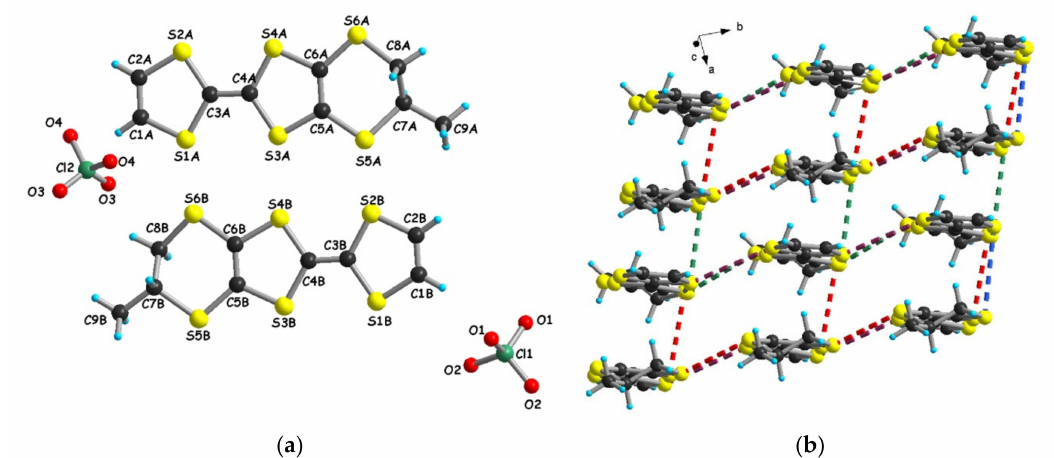
Figure 2. ( a ) Molecular structure of [( R )- 1 ] 2 ClO 4 along with the atom numbering scheme; ( b ) Donor layer with an emphasis on the S ··· S short contacts: red dotted lines (3.52–3.54 Å), blue dotted lines (3.81 Å), green dotted lines (3.62–3.63 Å) and violet dotted lines (4.02 Å).